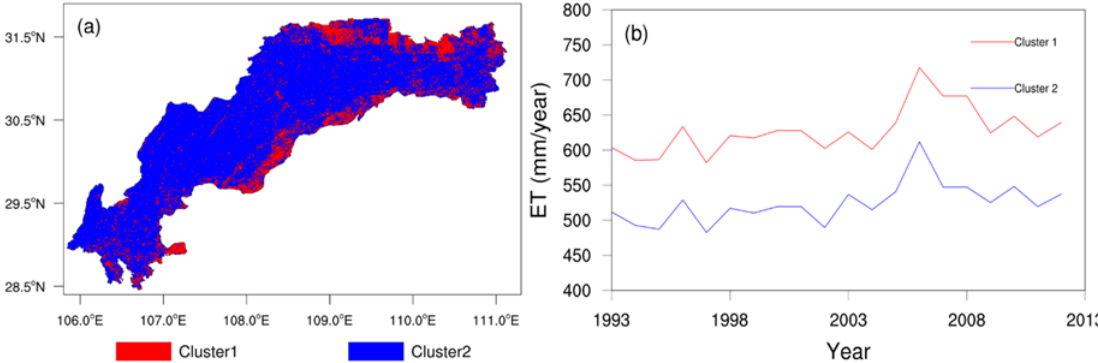
Figure 12. Cluster analysis results of the ET trend. ( a ) Spatial distribution of cluster of the ET trend; ( b ) Time series of annual ET of each cluster.